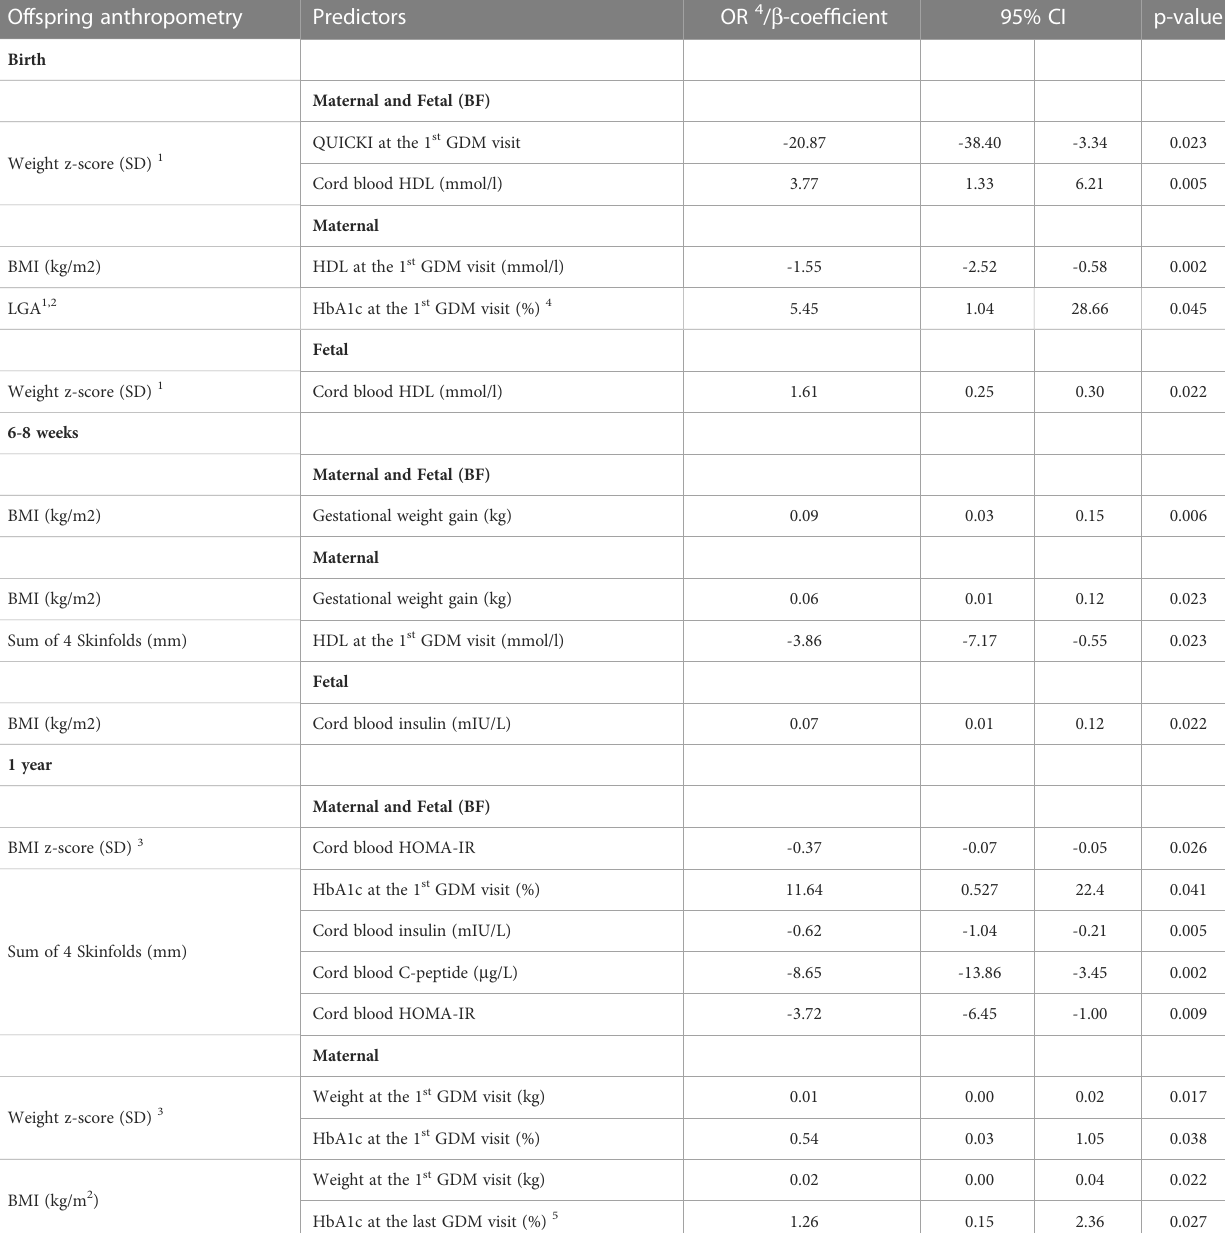
TABLE 2 Maternal and fetal predictors of infant anthropometry in multivariate regression analysis. Offspring anthropometry